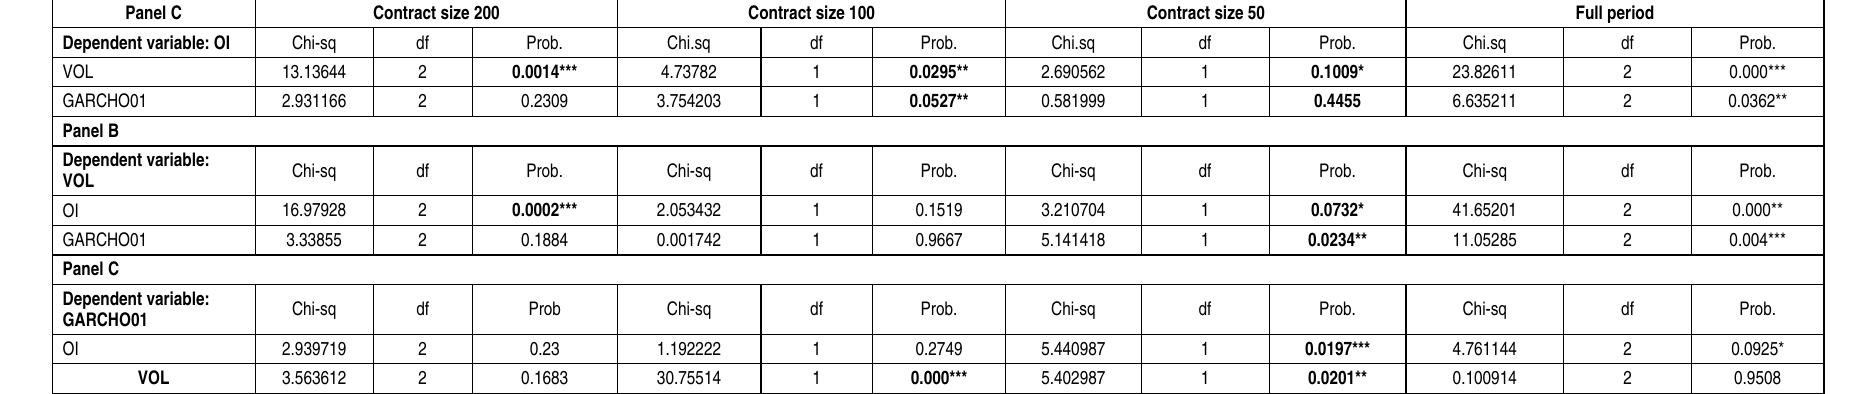
Table 2. Granger causality between open interests (OI_100), Volume (VOL_100) and return volatility (GARCH01) over three sub-periods for contract size starting with 200 (second column), followed by 100 (third column), 50 (fourth) and, finally, for the full period (fifth column) Panel C Contract size 200 Contract size 100 Contract size 50 Full